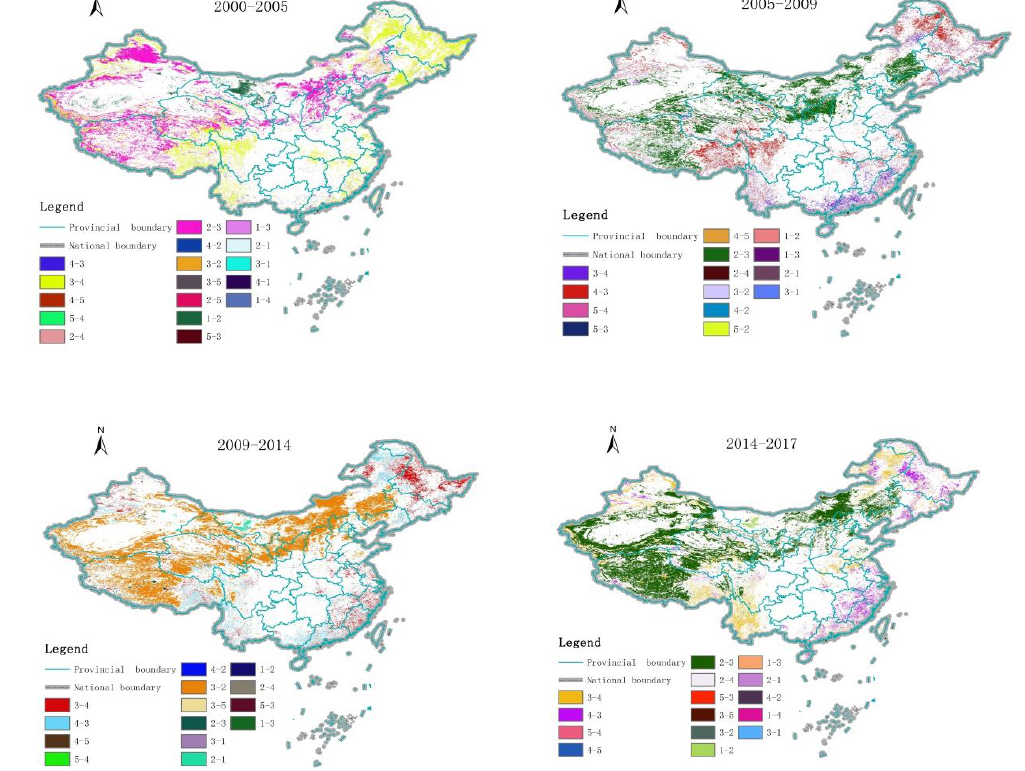
Figure 5. Spatial transfer distributions of the ecological levels of the RSEI in China in 2000 – 2017.